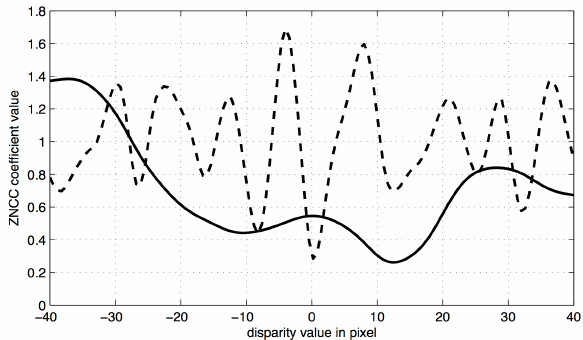
Figure 3: The unary terms (solid line) computed with the image pyramid ( k = 8 ) poorly represent the energy manifold (dashed line).